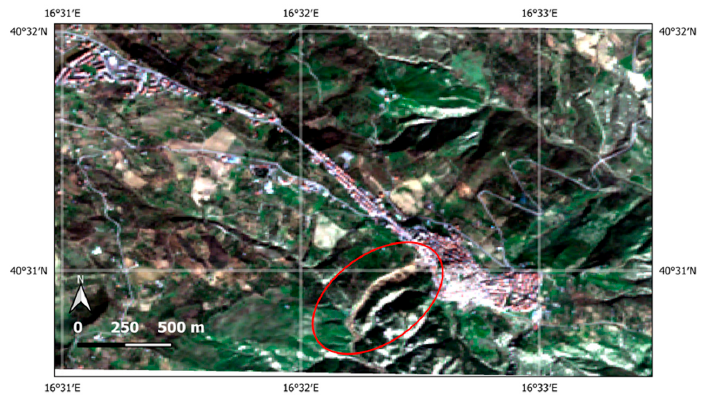
Figure 2. Sentinel-2B RGB (R = 0.665 μ m (band 4), G = 0.560 μ m (band 3), B = 0.490 μ m (band 2)) image of 9th February 2019 at 09.40 GMT. The area affected by the landslide is in the red ellipse.